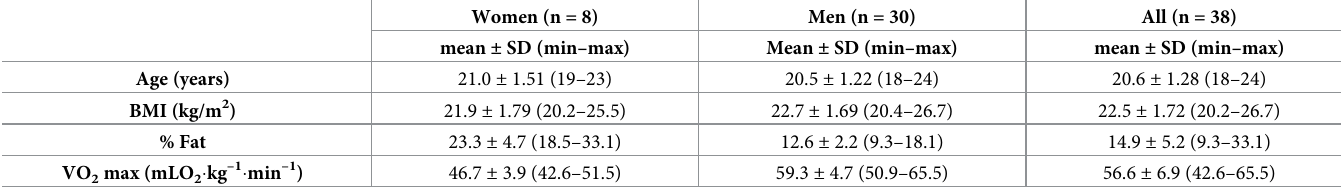
Table 1. Characterization of the